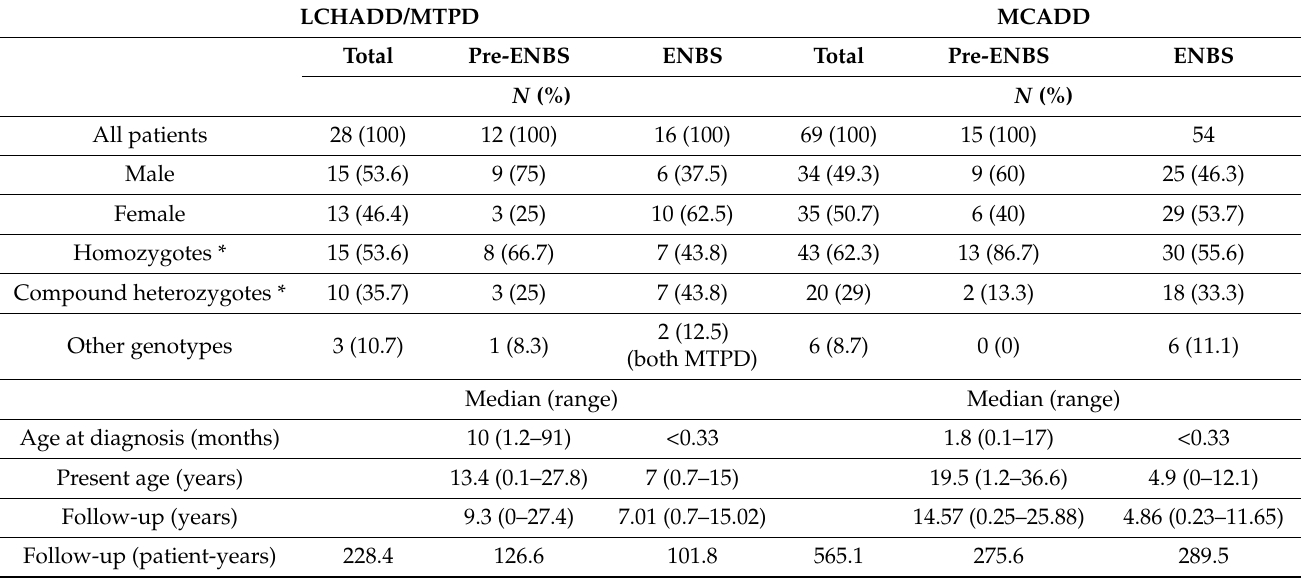
Table 1. Basic characteristics of LCHADD/MTPD and MCADD